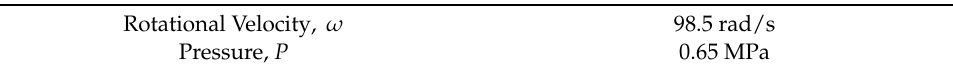
Figure 5. Boundary conditions of structural analysis model. Table 3. Boundary condition.